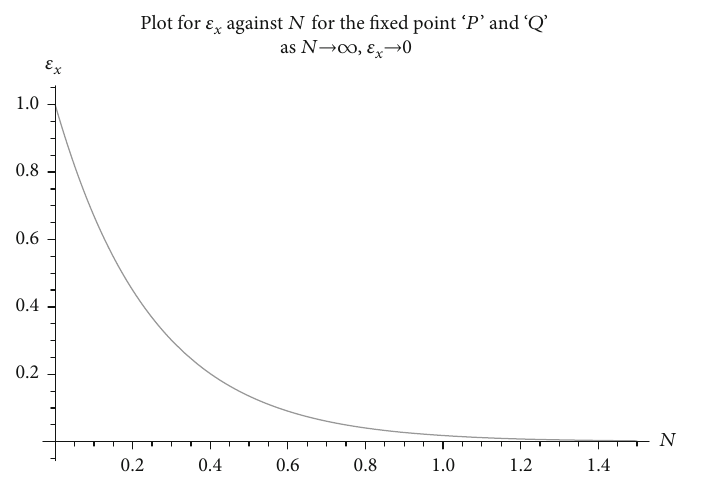
N ) against N for fi xed points P and Q . x